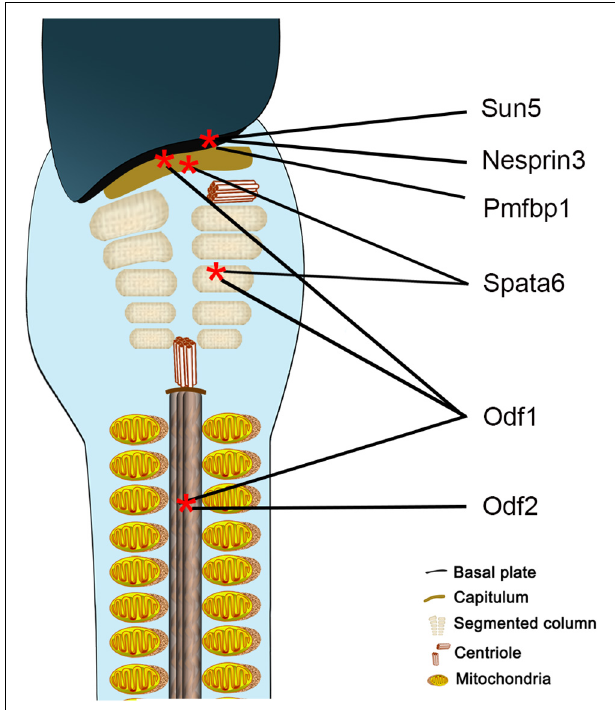
FIGURE 8 | Schematic representation of localization of proteins involved in sperm head-to-tail connection. Sun5, Nesprin3, and Pmfbp1 are located at the implantation fossa, Spata6 at the capitulum and segmented column, Odf1 at the HTCA and flagellum, and Odf2 at the